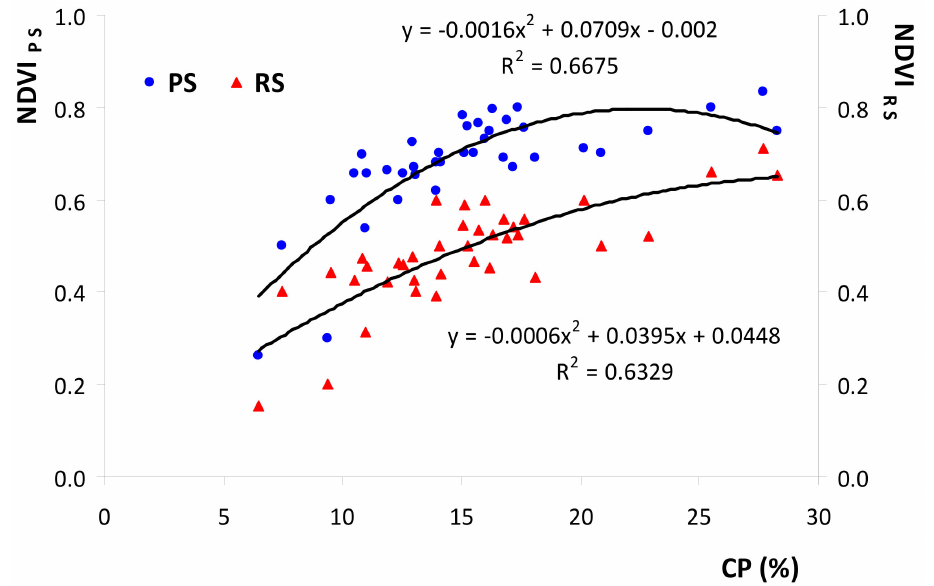
Figure 10. Correlation between vegetation index values (obtained by proximal sensors, NDVI PS , and by remote sensing, NDVI RS ) and pasture crude protein